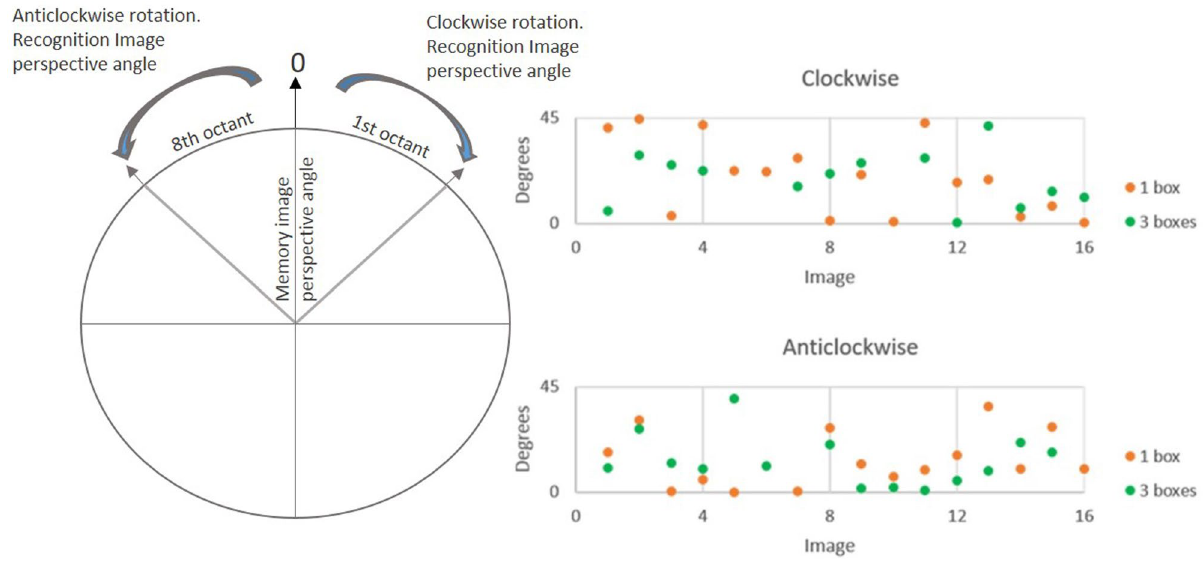
Figure 3. Rotation angle (in degrees) of each viewpoint of recognition image as a function of Difficulty (one box and three boxes) and Direction (clockwise and